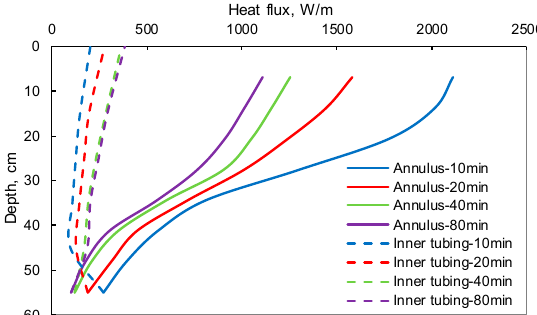
Figure 7. Heat flux along the wellbore at different times.